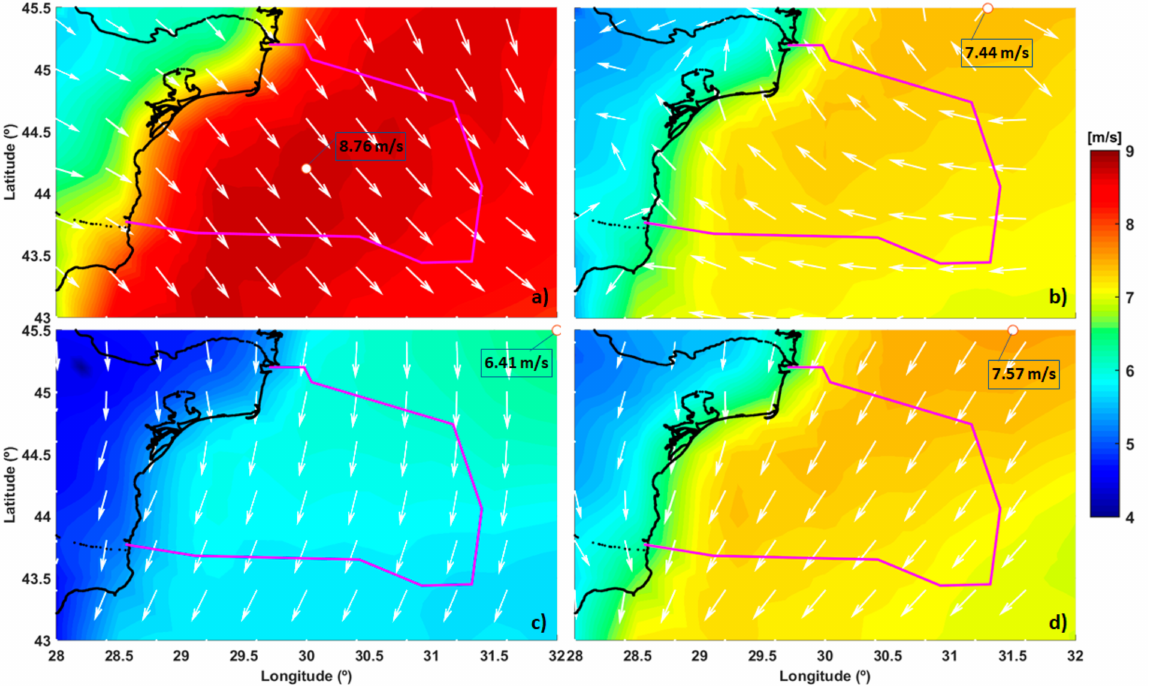
Figure 6. The seasonal averaged wind speed as indicated by the ERA5 ( U 100 ) dataset for the Romanian coastal area over the time interval 2000–2019. Data corresponding to the following seasons are presented: ( a ) winter—December– January–February; ( b ) spring—March–April–May; ( c ) summer—June–July–August; and ( d ) autumn—September–October– November. The results include the wind direction vectors and the locations of the maximum wind speed, while the Romanian EEZ is indicated by the magenta